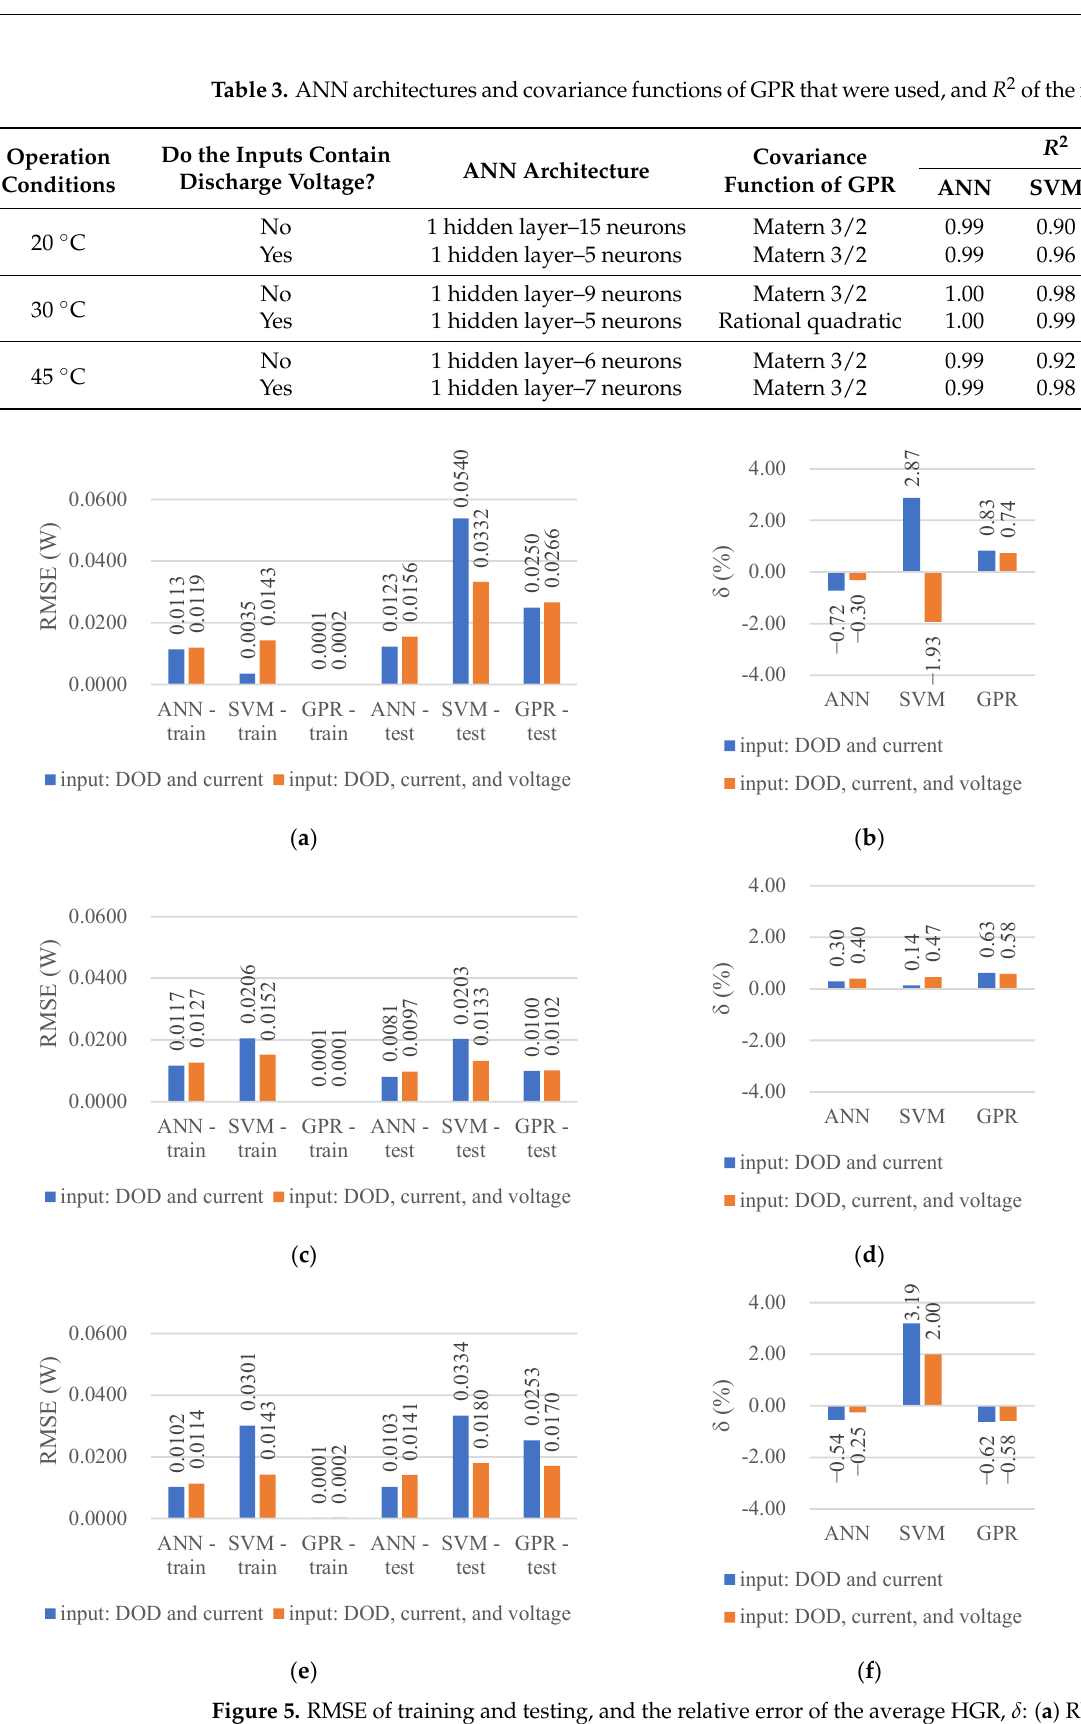
Figure 5. RMSE of training and testing, and the relative error of the average HGR, δ : ( a ) RMSE values of discharge at 20 °C; ( b ) δ of discharge at 20 °C; ( c ) RMSE values of discharge at 30 °C; ( d ) δ of discharge at 30 °C; ( e ) RMSE values of discharge at 45 °C; ( f ) δ of discharge at 45 °C.